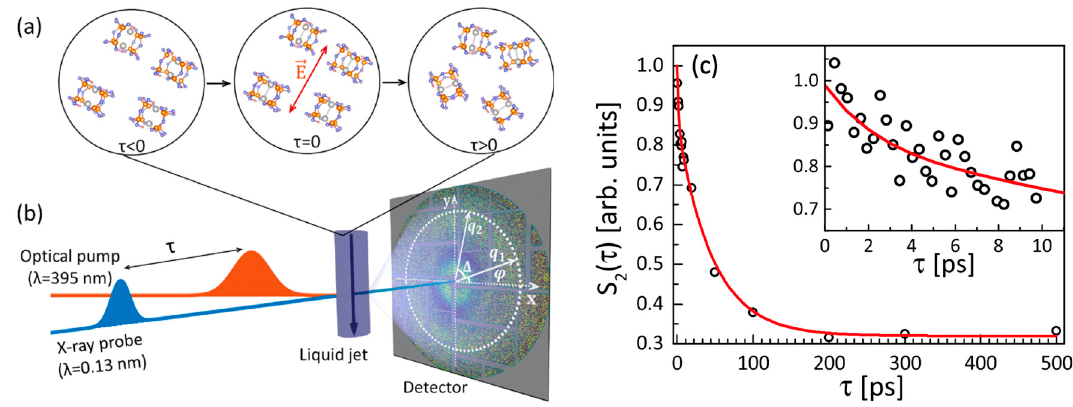
Figure 18. ( a ) Temporal evolution of an ensemble of randomly oriented tetrakis- µ -pyrophosphitodiplatinate (II) (PtPOP) molecules before ( τ < 0) and after ( τ ≥ 0) excitation. Only the molecules with the transition dipole moment (along the Pt-Pt axis) parallel to the laser field E are excited at τ = 0; ( b ) Scheme of the optical pump X-ray probe experiment at LCLS. On the detector, the di ff erence di ff raction pattern averaged over N ≈ 3000 shots is shown; ( c ) Temporal decay with the time constant 46 ± 10 ps of the value S 2 ( τ ) , which is normalized area under the peak at q = 1.8 Å − 1 of the second Fourier component of the CCF (cid:104) C 2 ( q , τ ) (cid:105) . The faster decay of S 2 ( τ ) with the time constant 1.9 ± 1.5 ps is shown in inset (adapted from [58]). Used under CC-BY 4.0.